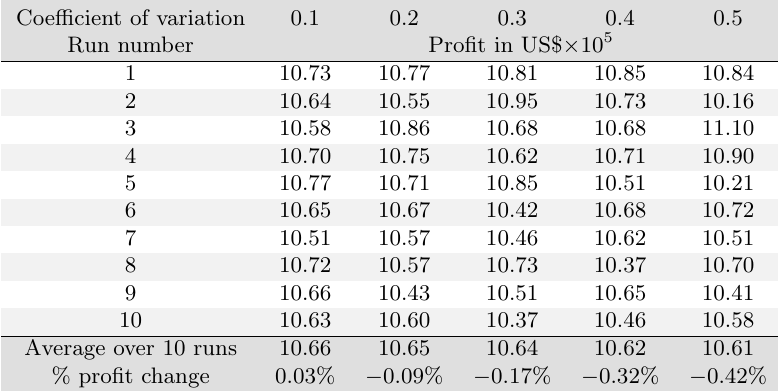
Table 6: Profit from random catch and variable trawler schedule for IFPM.